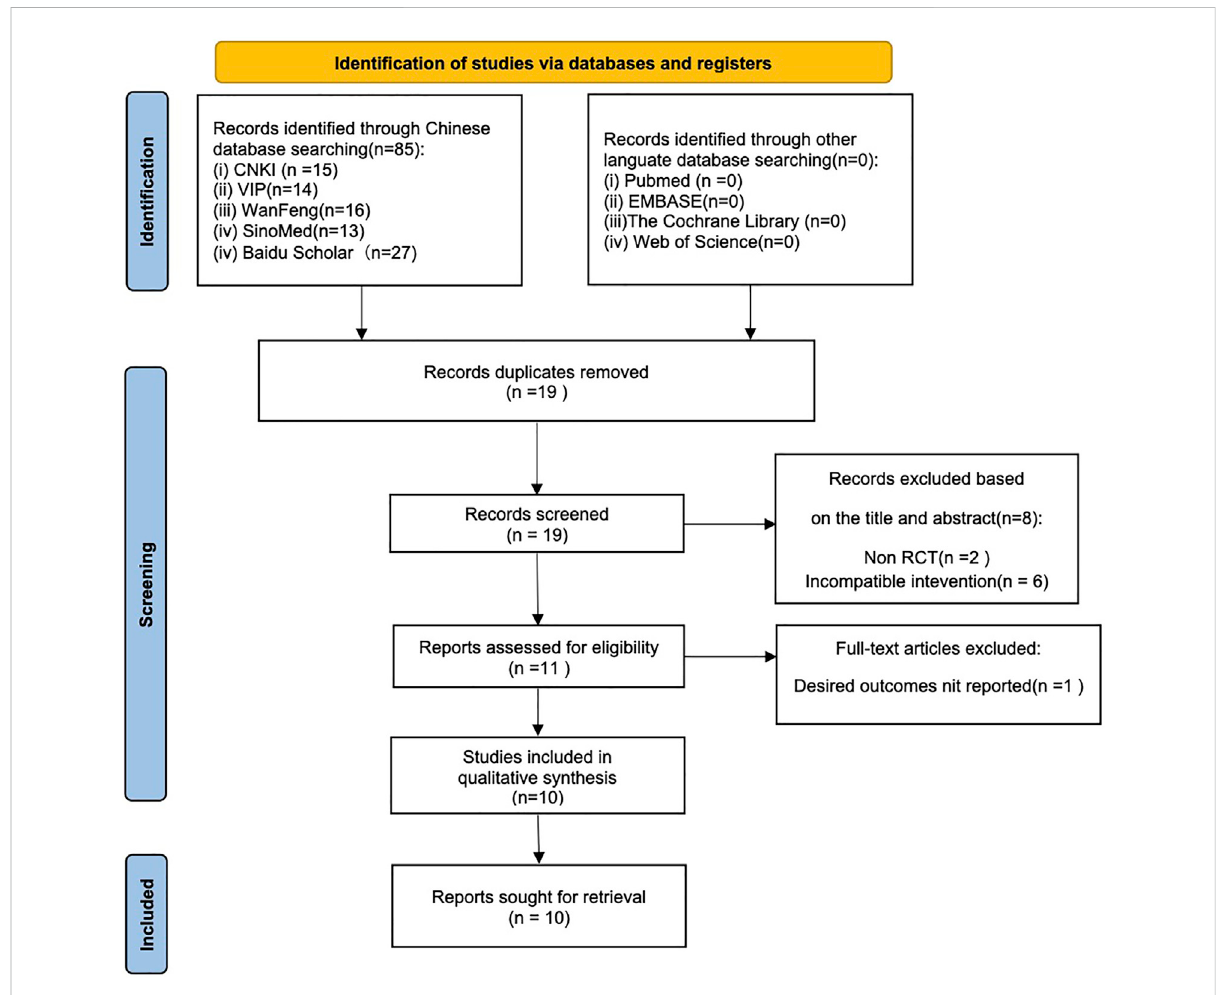
FIGURE 2 Flowchart showing the study screening